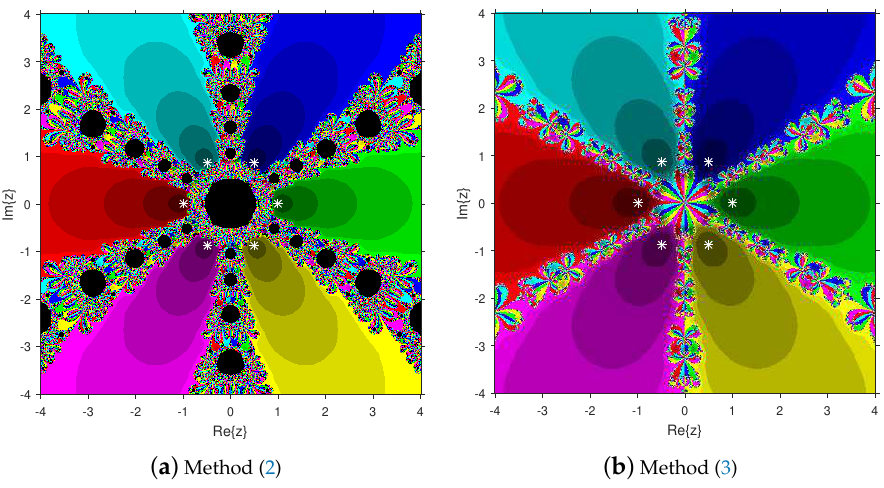
Figure 5. Comparison of attraction basins associated with sixth-degree polynomial O 5 ( z ) = z 6 − 1.